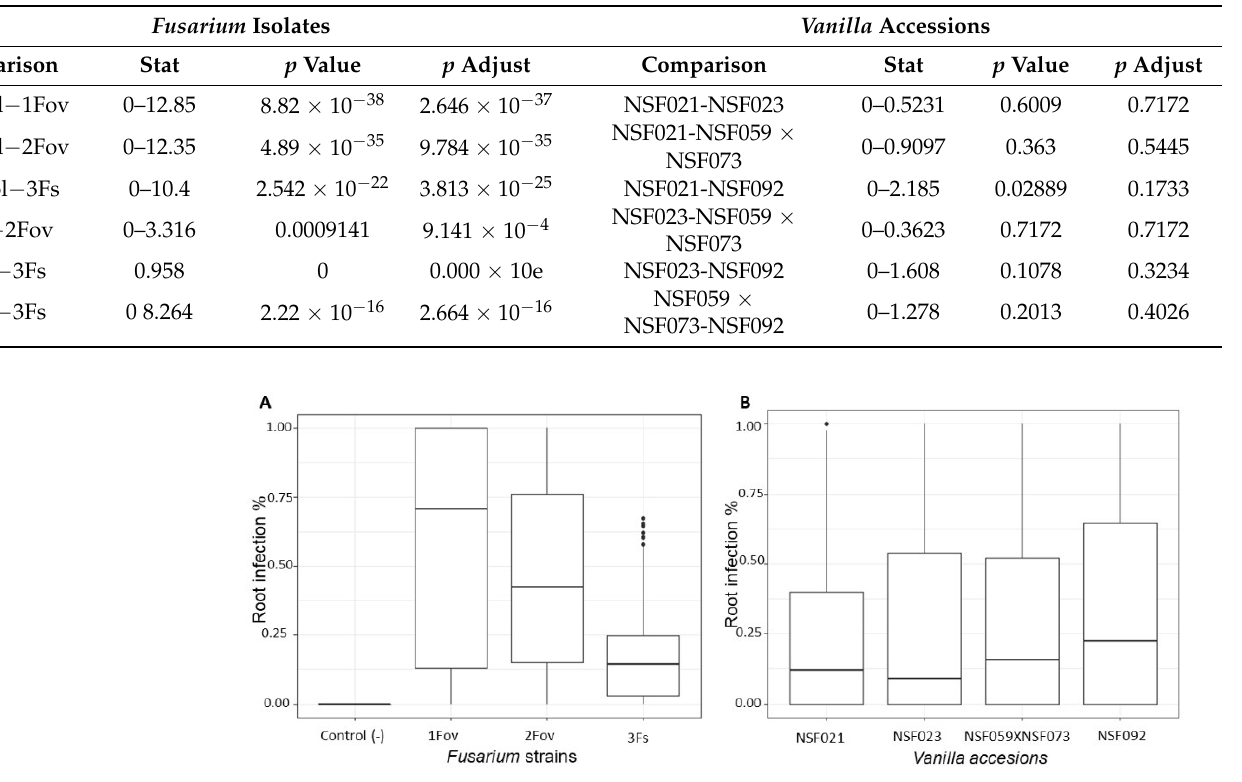
Figure 4. ( A ) Plot of design factor designated as Fusarium isolates; The atypical points of the 3Fs isolate belongs to the percentage of infected root in the accessions NSF092 (Points 1,2, 4 and 6 from top to bottom), NSF023 (point 3) and NSF056XNSF073 (point 5), and ( B ) design factor graphic designated as vanilla accessions; The atypical point illustrated in the image belongs to a repetition of the NSF021 accession with the 1fov isolate .